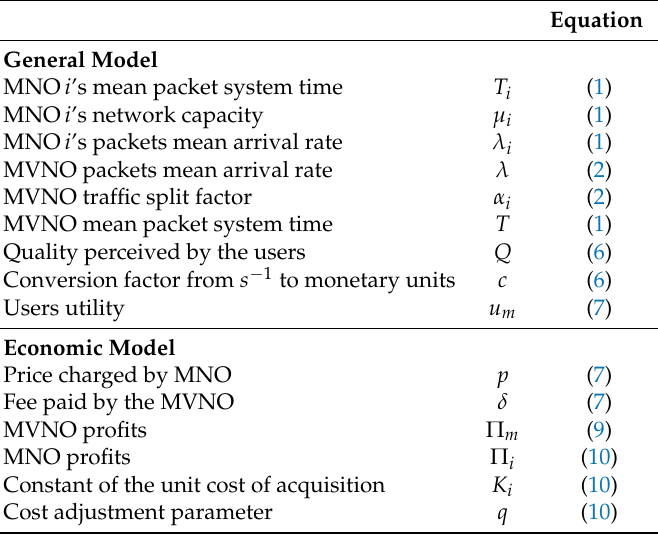
Table 1. Summary of